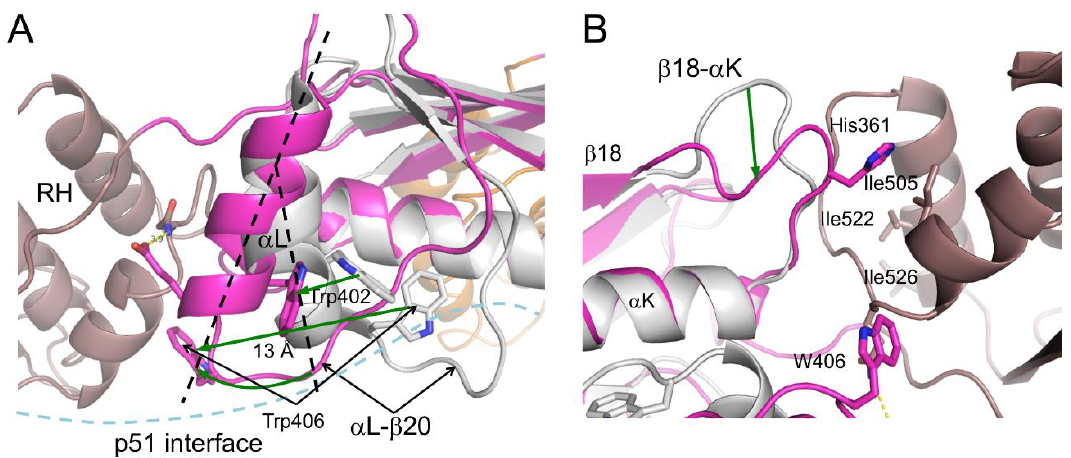
Figure 8. Formation of the connection:RH interface. ( A ) Superposition of the connection:RH interface region of the p66 subunit of the RT heterodimer (color coded as in Figure 2) with the monomer connection domain (gray). Formation of the connection:RH interface requires straightening of helix α L, which also requires movement of the α L– β 21 loop. These adjustments are required to form both the intra-subunit connection:RH interface and the inter-subunit connection:connection’ interface. Trp406 moves approximately 13 Å to make contact with the RH domain (the α -carbon displacement is 11 Å); ( B ) Rotated view illustrating movement of the β 18– α K loop and conformational changes at the connection:RH interface that result in several of the observed RH domain Ile shifts previously reported [24]. Black hyphenated lines indicate the altered helix structure, and green arrows indicate conformational changes.